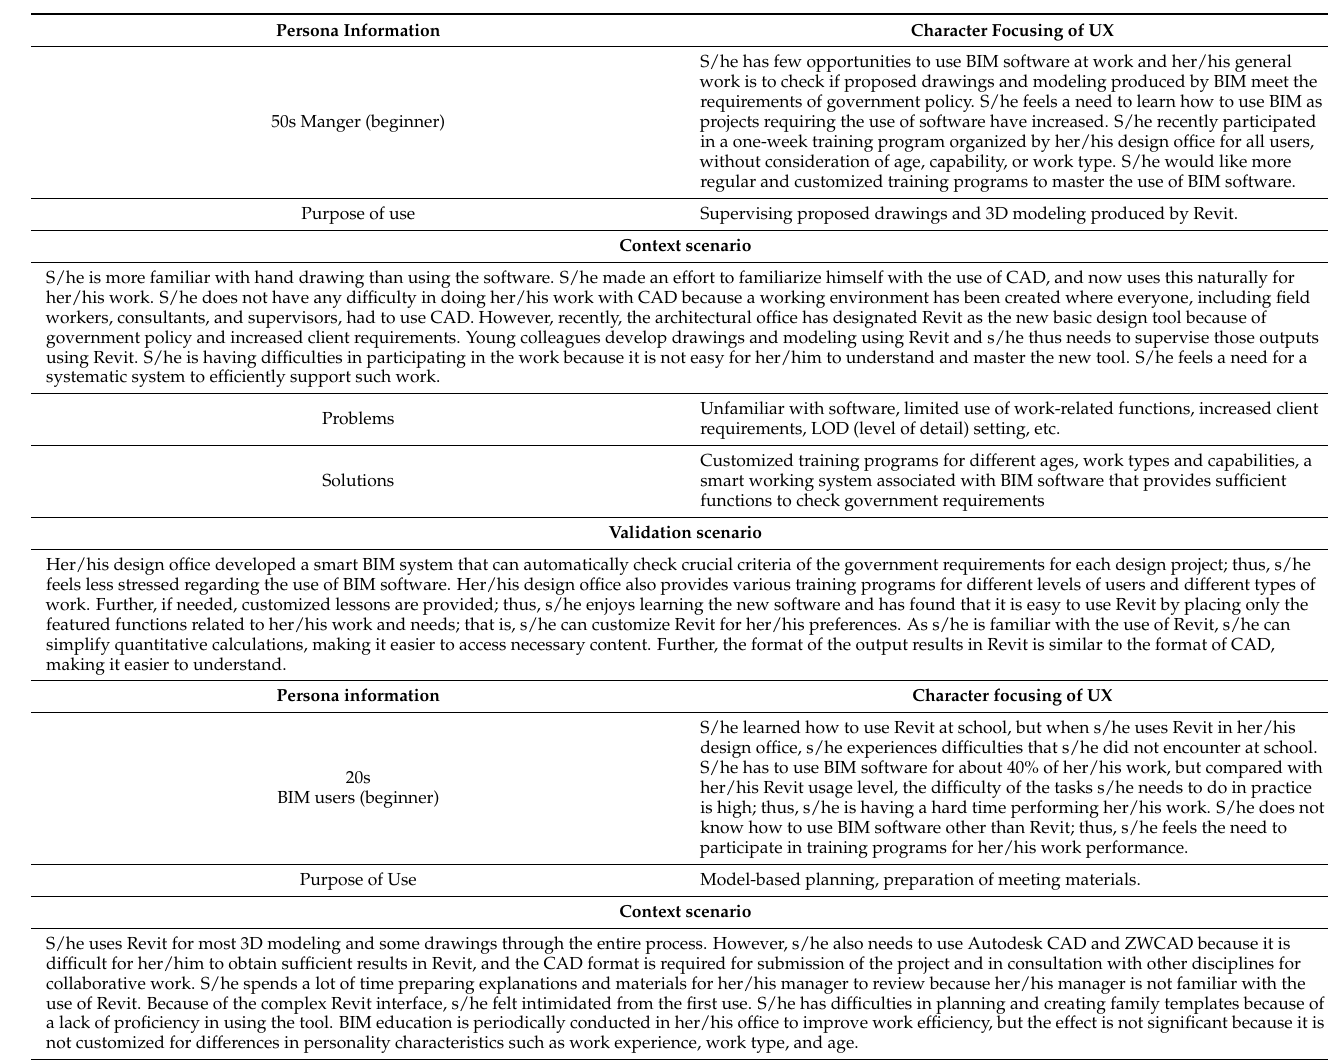
Table 4. An example of persona UX